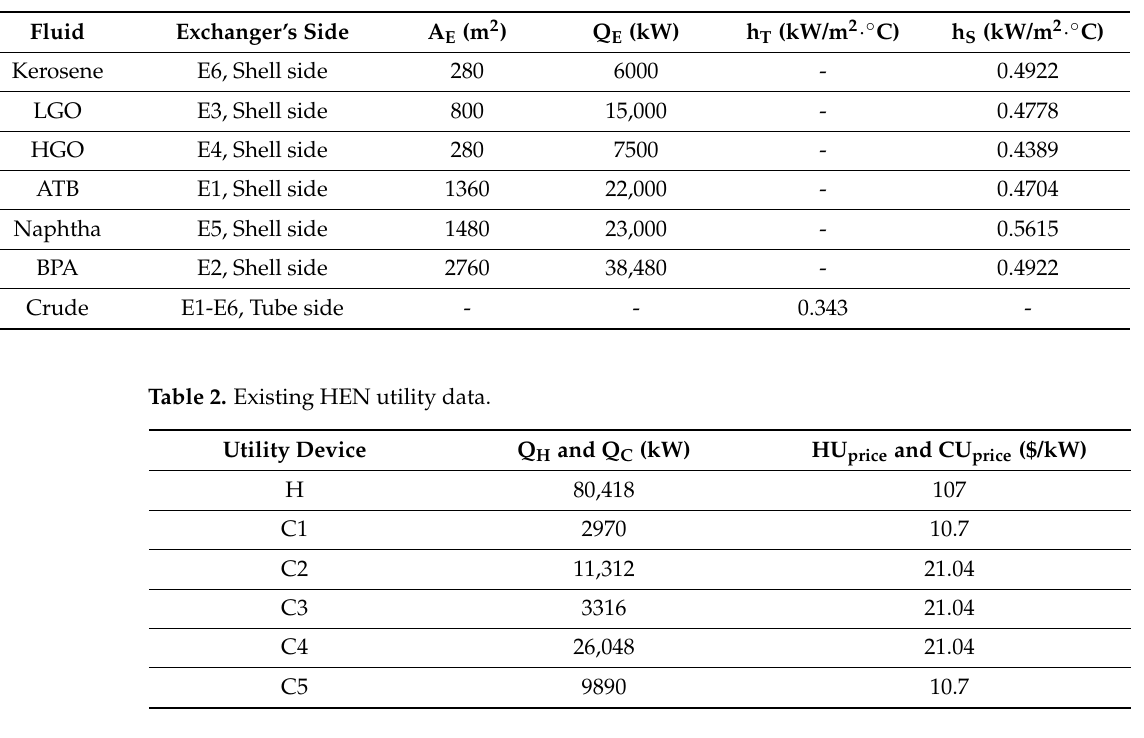
Table 1. Existing HEN steams’ data.